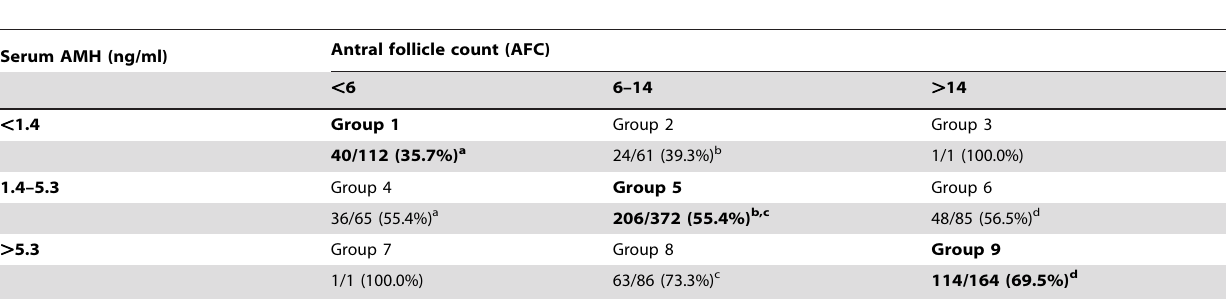
Table 3. Cumulative live birth rate in different subject groups classified according to the quartile of serum AMH and AFC.